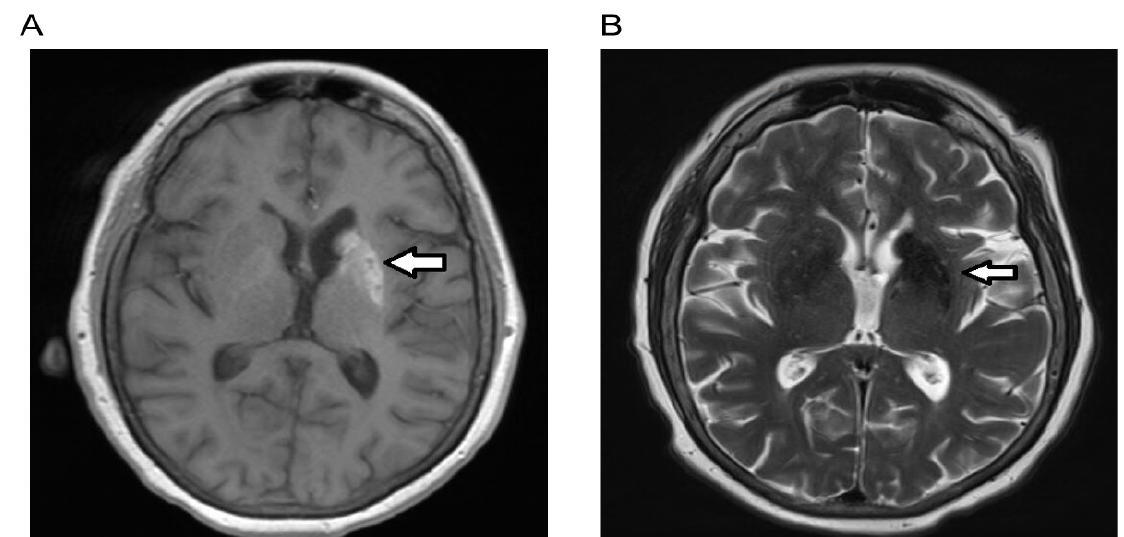
Image 2. Magnetic resonance imaging of brain showing nonketotic hyperglycemia. (A) shows T1-weighted fluid-attenuated inversion- recovery (FLAIR) imaging with hyperintensity (arrow) in correlation with computed tomography imaging as seen Image 1. (B) on T2-FLAIR and diffusion-weighted imaging signal is hypointense (arrow) with no surrounding edema. This supports nonketotic hyperglycemia rather than acute